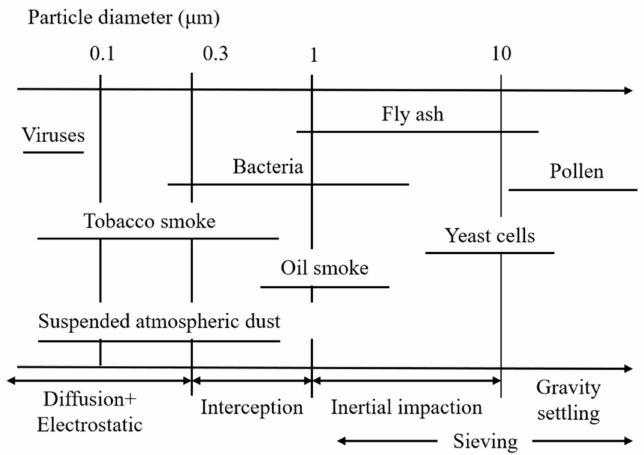
Figure 2. The particle size of common air pollutants corresponding to di ff erent filtration